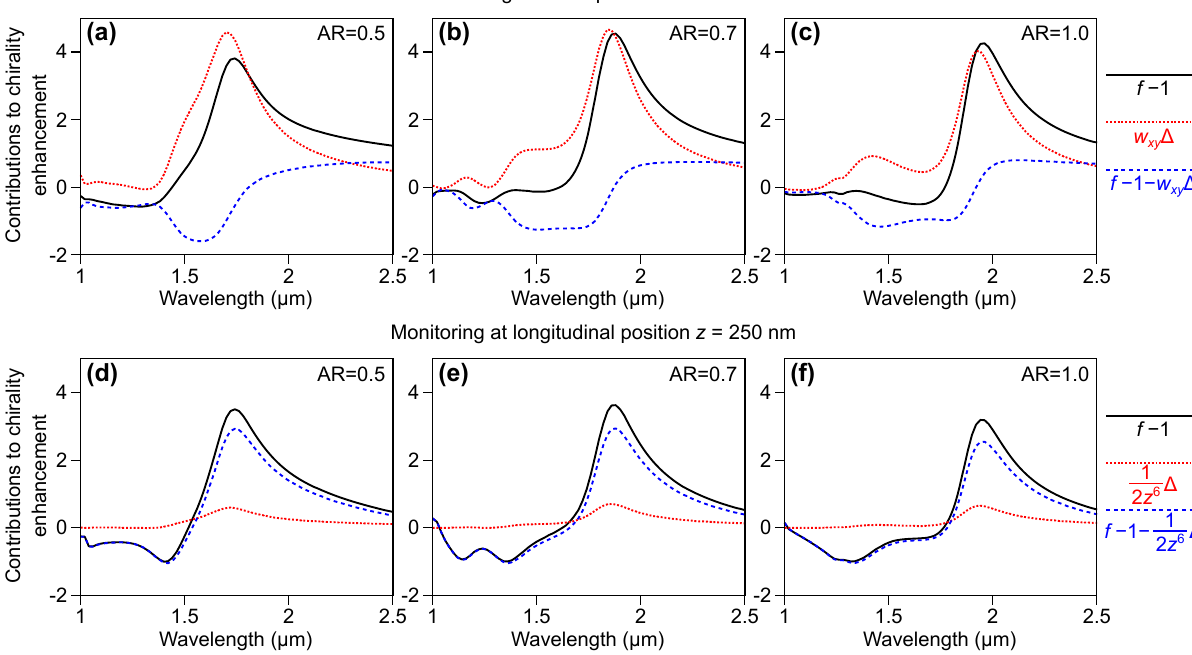
Figure 4: Various contributions to chirality enhancement ( f ) spectra in dipolar approximation: chirality enhancement minus one, term proportional to Δ = | 𝛼 + | 2 − | 𝛼 − | 2 and the remaining part that depends on 𝛼 + (independent on 𝛼 − ). Selected values of aspect ratio are being used. Top: at a single point with r = 250 nm, at a single point with z = 250